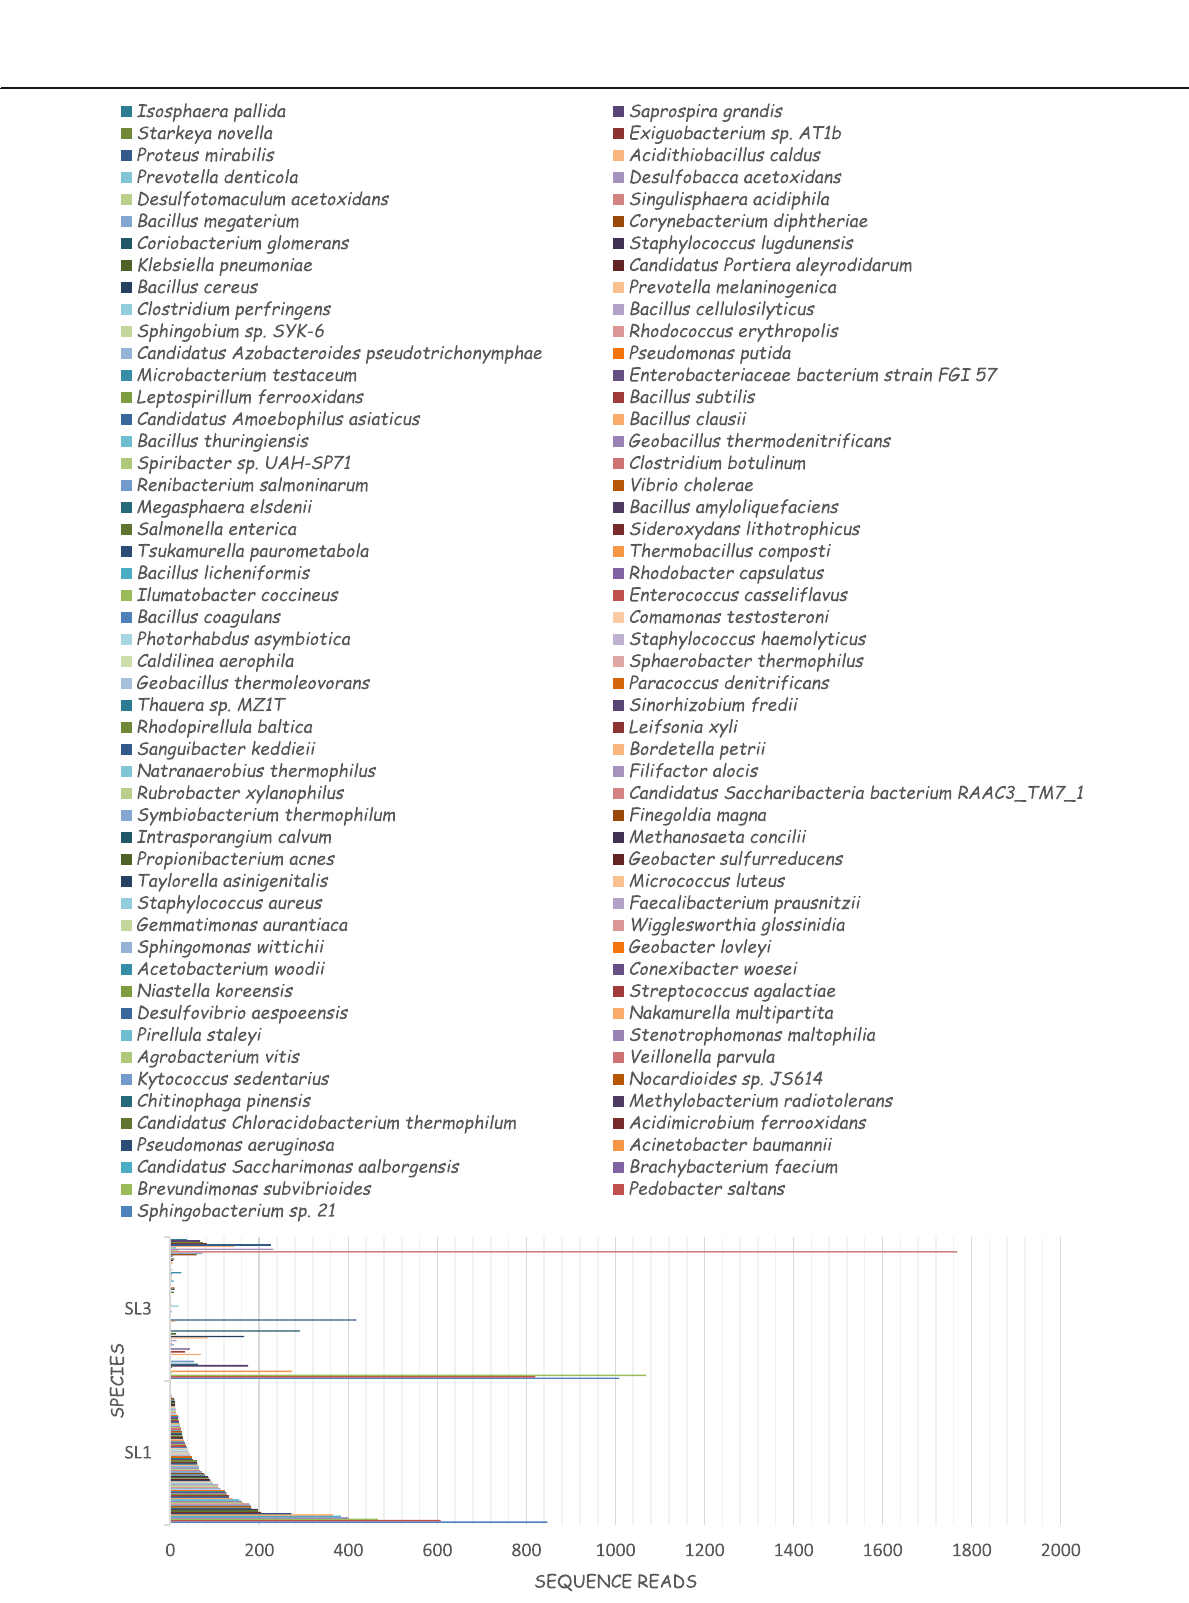
Fig. 6 Species classification of SL1 and SL3 metagenomes. Unclassified reads were not used. Only species with ≥ 10 sequence reads were used for the